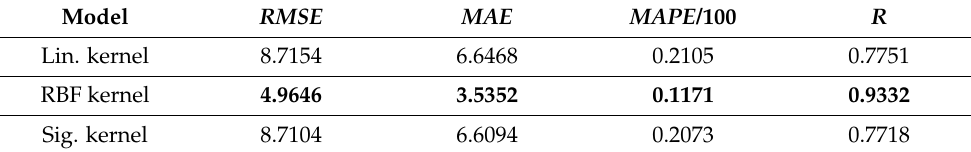
Table 6. Comparative analysis of results using linear, RBF and sigmoid kernel in SVR method. Model RMSE MAE MAPE/